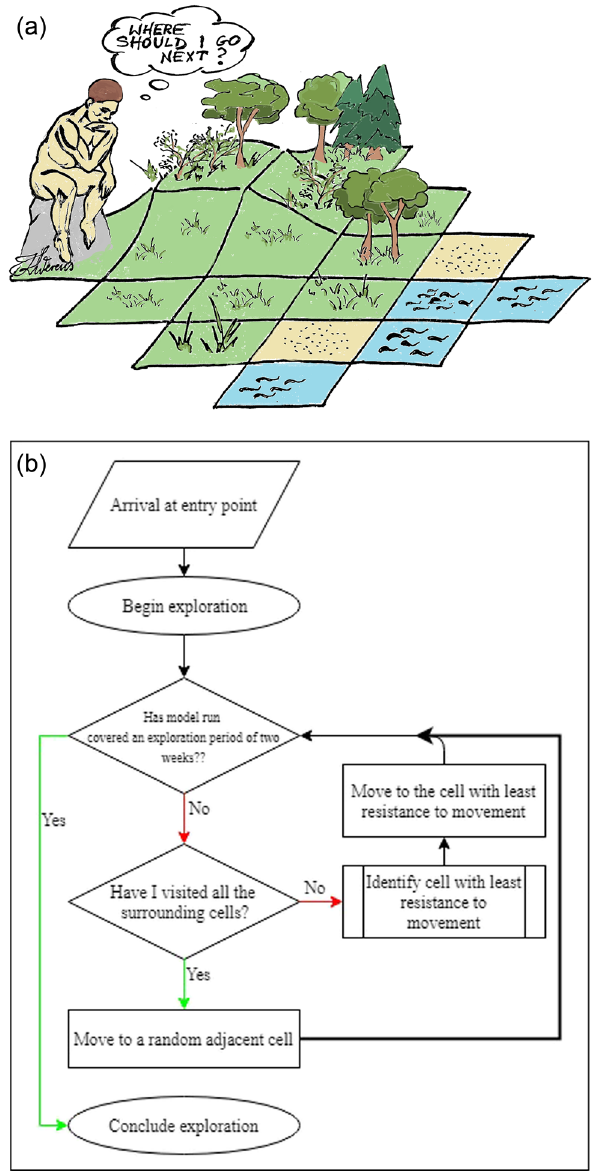
Figure 3: ( a ) An agent on a cell of land considering where to explore next; ( b ) fl owchart showing the decision - making of an individual